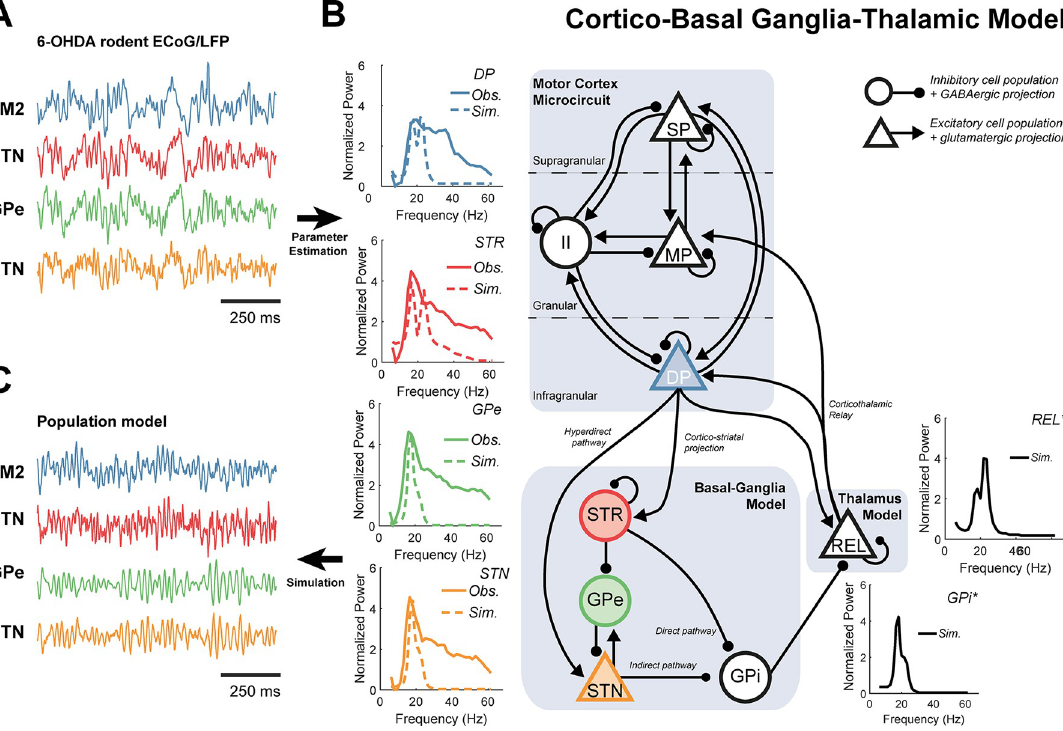
Fig 1. Schematic of the cortico-basal ganglia-thalamic model and fit to empirical data from Parkinsonian rodents. A model describing the population activity in this circuit was fit to data features (power spectra and directed functional connectivity) of (A) electrophysiological recordings: electrocorticography from motor cortex M2 (blue) as well as local field potentials from striatum (STR; red) external segment of the globus pallidus (GPe; green) and the subthalamic nucleus (STN; yellow) made in a 6-OHDA-lesioned rodent model of Parkinsonism. Data were normalized and band-passed at 4–100 Hz before being transformed to the data features used to estimate parameters. (B) Schematic of model architecture, detailing excitatory/glutamatergic projections (triangular nodes with arrows) and inhibitory/GABAergic projections (circular nodes with ball ended arrows). The motor cortex microcircuit comprises three layers: superficial pyramidal cells (SP; supragranular); middle pyramidal (MP; granular); and deep pyramidal cells (DP; infragranular), plus an inhibitory interneuron population (II). The basal ganglia model comprises four populations: STR, GPe, STN, and internal segment of the pallidus (GPi). The GPi forms the output of the basal ganglia and acts to inhibit relay cells of the ventrolateral thalamus (REL). GPi and REL were treated as hidden nodes and their respective neural activities were inferred from the dynamics of the empirically recorded brain regions. The main subcortical pathways include the direct, indirect, hyperdirect, and cortico-thalamic interactions. The inset graphs indicate the empirical and simulated power spectra in bold and dashed lines, respectively. For the full set of empirical and fitted data features please see S1 Fig. (C) Simulations of this circuit yields time series with transient, burst like behaviour similar to that seen in vivo